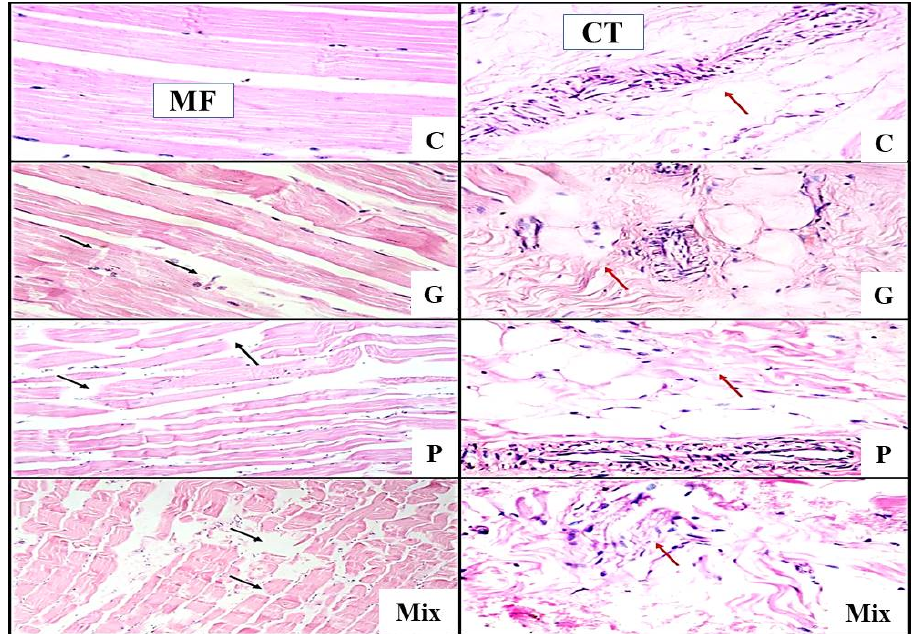
Figure 1. Light micrograph of camel semitendinosus muscle stained with H&E (×40). C: control; G: ginger extract; P: papain-enzyme powder; Mix: a mixture of ginger and papain; MF: muscle fiber; CT: connective tissue. Black arrows point to fiber breaks in muscle fibers; red arrows point to connective tissue.